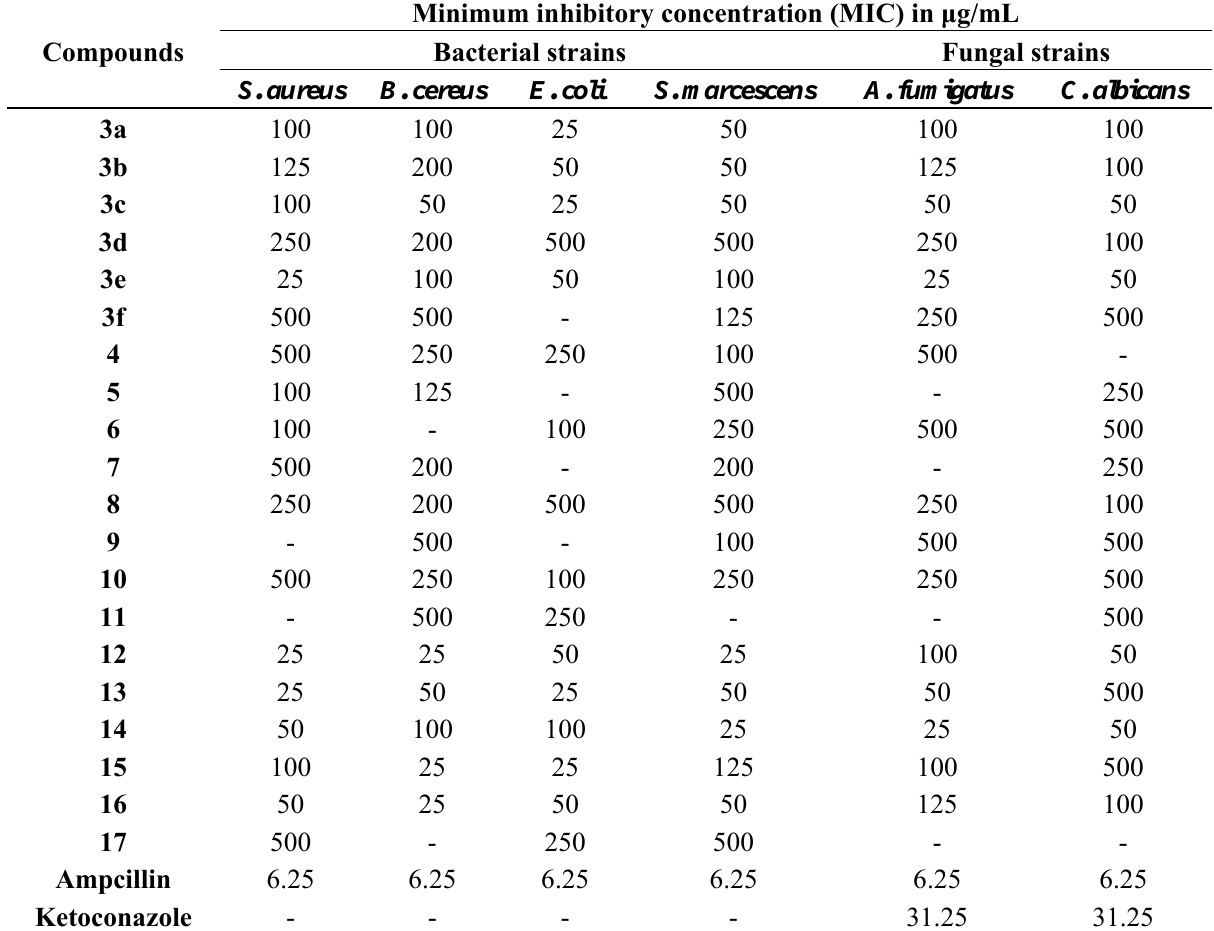
Table 1. Antimicrobial activity of the new compounds .